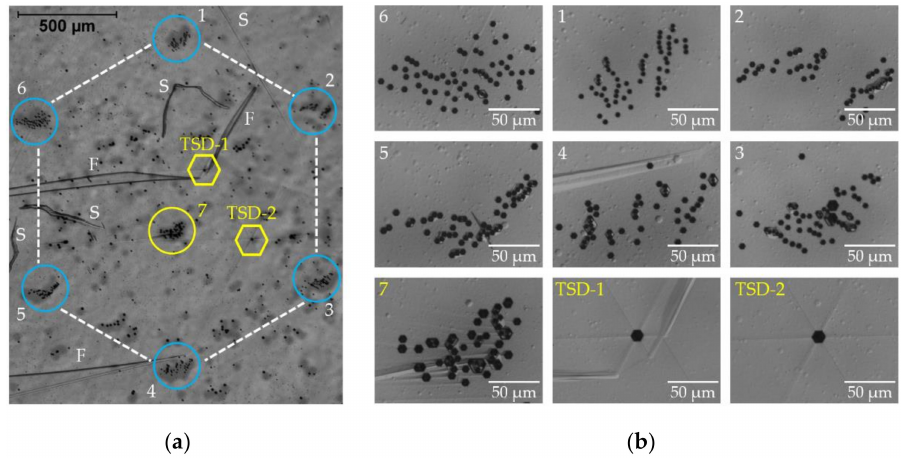
Figure 7. ( a ) DIC optical image of the etched HCD shown in Figure 5c. The corners of the hexagon are formed by TEDs. Growth facets (F) and scratches (S) are also visible. ( b ) Enlarged images of the etch pits formed on the bundles of TEDs (1-6). Other pits of dislocation bundles (like the one labeled 7) are of mixed type and two pits of single threading screw dislocations (TSD-1 and TSD-2) are